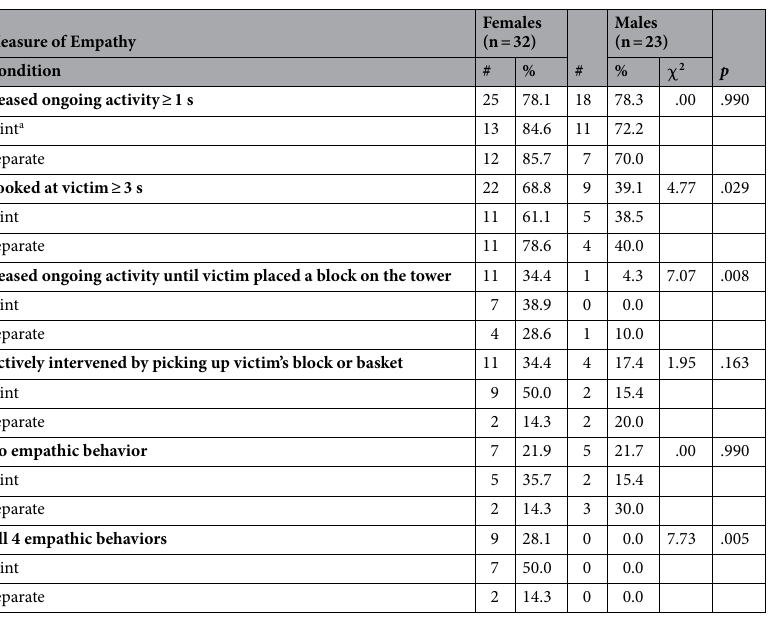
Table 1. Number of female and male bystanders who engaged in each measure of empathy in order of frequency of occurrence. a 18 female and 13 male pairs participated in the joint condition; 14 female and 10 male pairs participated in the separate condition. Cell counts were too low for statistical comparisons within